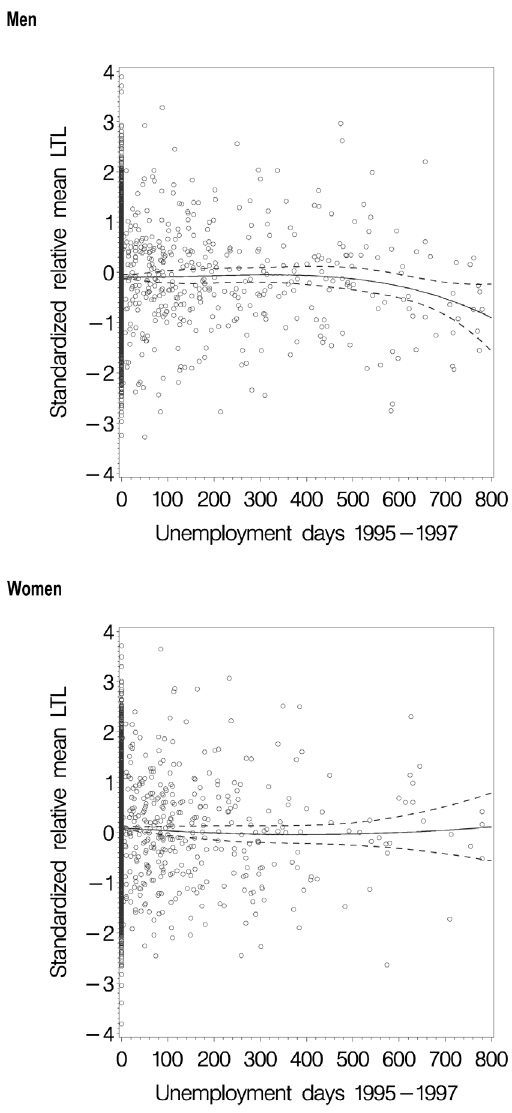
Figure 1. Scatterplots of LTL (standardized relative mean leukocyte telomere length) at follow-up in relation to the number of unemployment days in the preceding three years 1995–97. The lines indicate the LTL curves fitted to cubic function of unemployment days and the dashed lines their 95% confidence